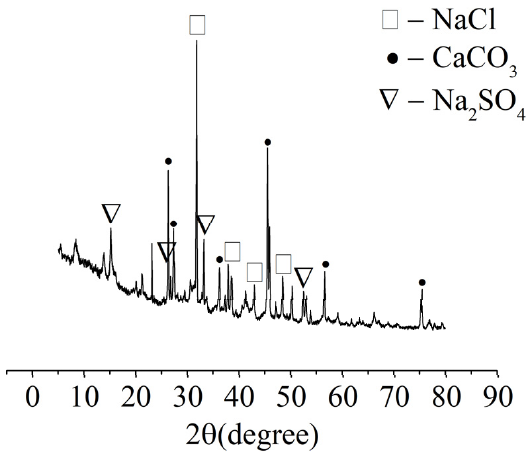
Figure 4. XRD analysis of the crystalline material on the surface of the specimens.